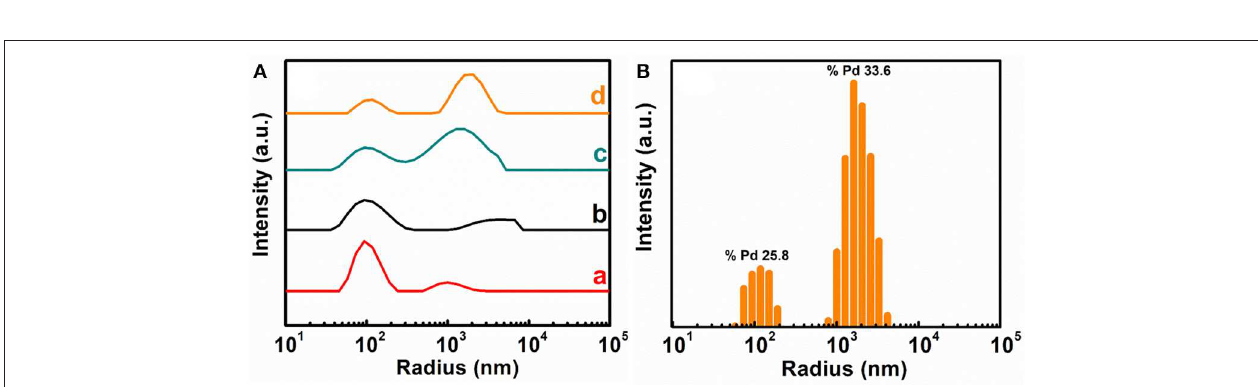
FIGURE 4 | (A) Average data (40 samples of each composition) for DLS analysis of (a) M-CB-MWCNT, (b) M-PV-MWCNT, (c) M-AA-MWCNT and (d) M-CP-MWCNT, (B) Typical spectrum for M-CP-MWCNT. The width of the peaks indicates the polydispersity of the aggregate (Pd).